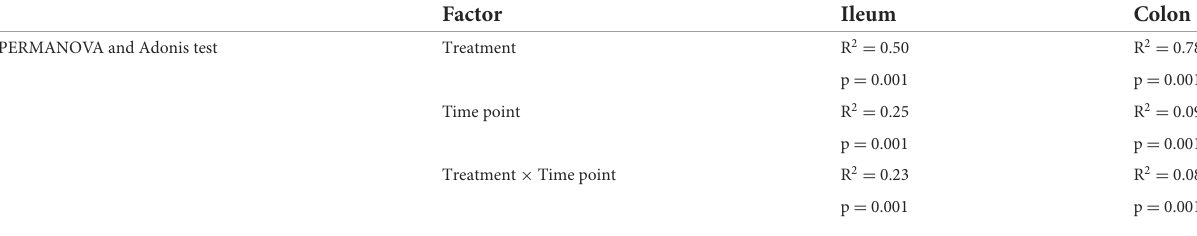
TABLE 2 Effects of the experimental factor on in vitro fermentation pig microbiota. Factor Ileum Colon PERMANOVA and Adonis test Treatment